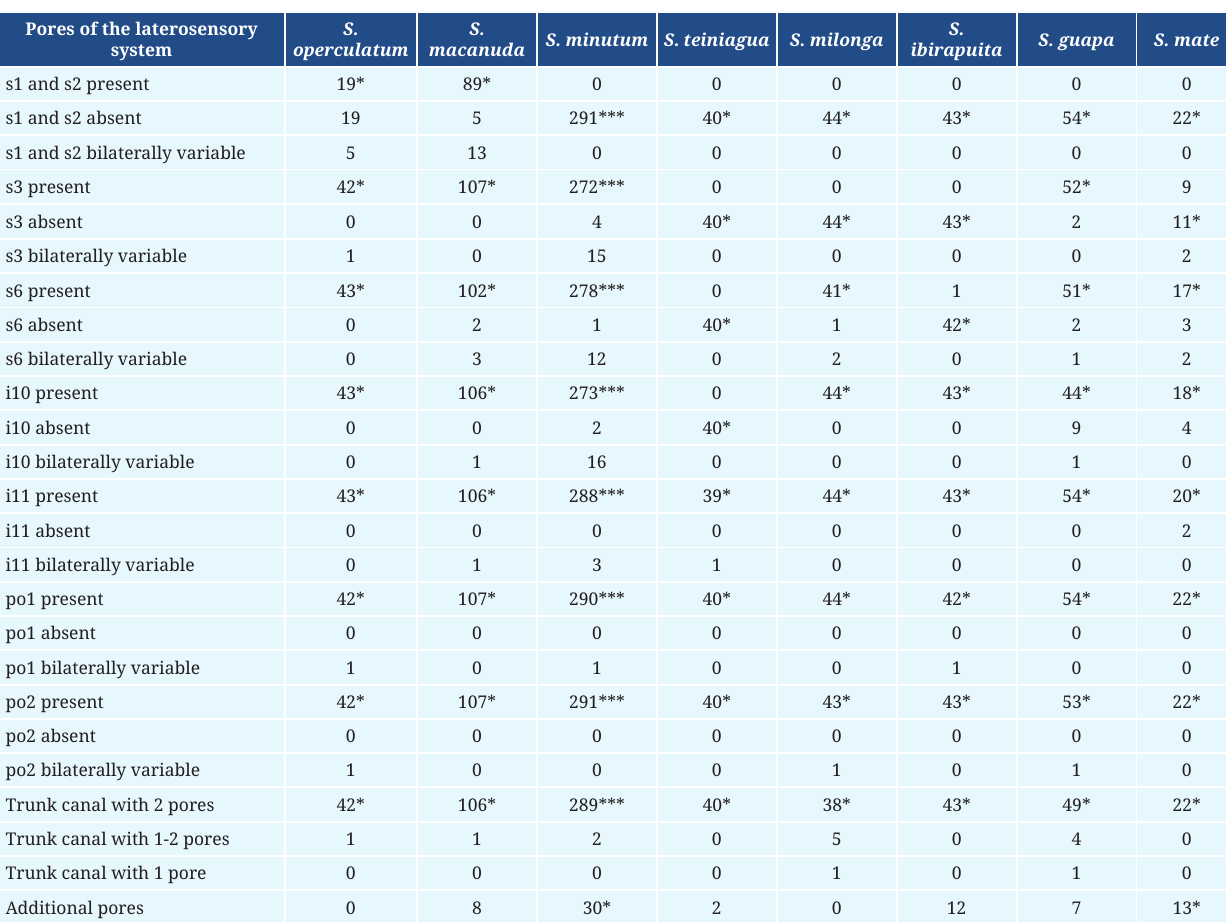
TABLE 3 | Distribution of pores of the laterosensory system for the species of Scleronema . Asterisks indicate the pattern present in the type specimens of Scleronema minutum and S. operculatum and the holotype for other species. Additional pores are present in the infraorbital line or posteriorly to the pore s6 of the supraorbital